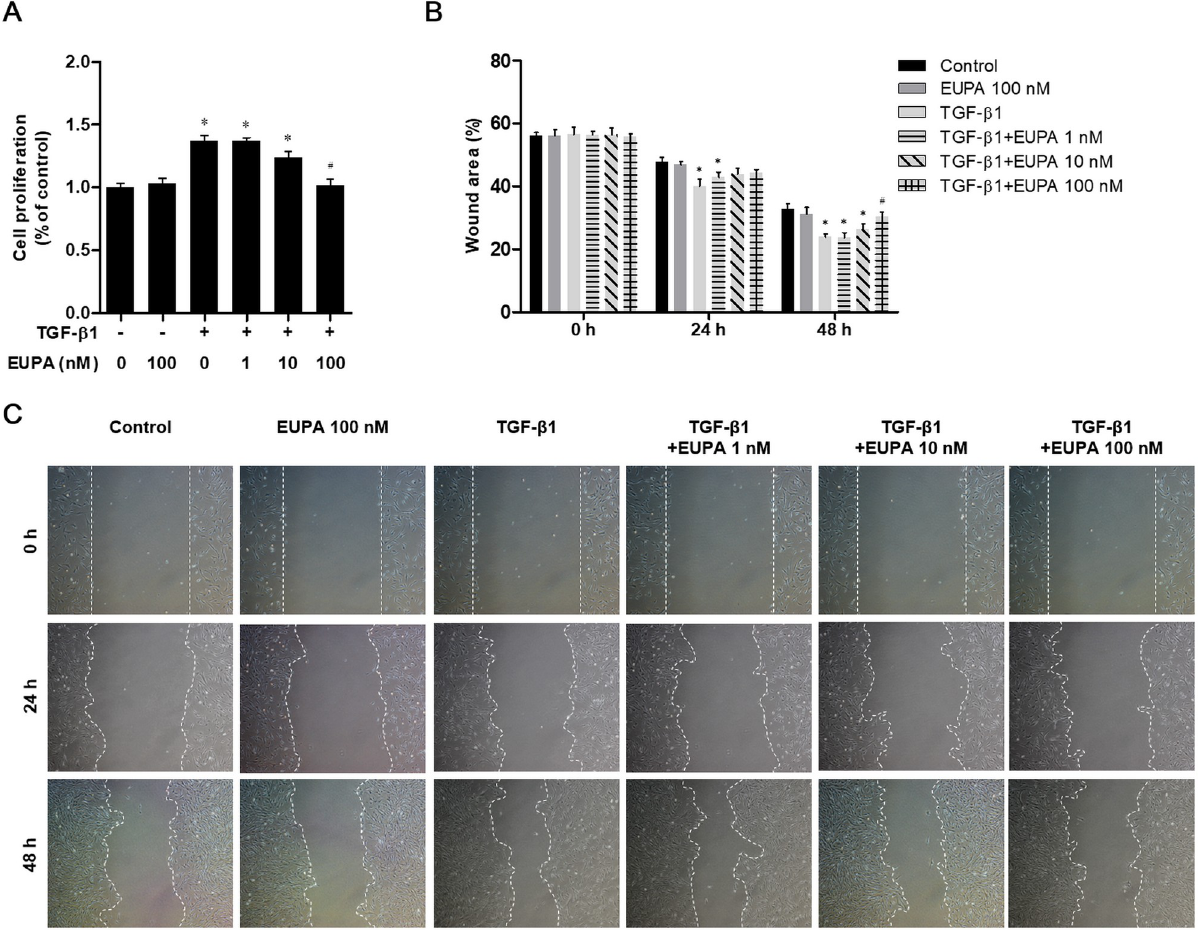
Fig 2. Effect of eupatilin on hVFFs proliferation and motility induced by TGF- β 1. (A) hVFFs were treated for 48 h with TGF- β 1 (10 ng/ml) plus 1, 10, or 100 nM eupatilin, or with 100 nM eupatilin alone. Cell proliferation was determined in an MTT assay. (B) Cell migration was evaluated by the wound healing assay. (C) Uncovered areas in the wound healing assays were quantified as the percentage of the original wound area. Data are representative of three independent experiments performed in triplicate and are expressed as the mean ± SEM. � p < 0.05 vs. TGF- β 1 untreated control (TGF- β 1 = 0 ng/ml).# p < 0.05 vs. eupatilin untreated control (eupatilin = 0